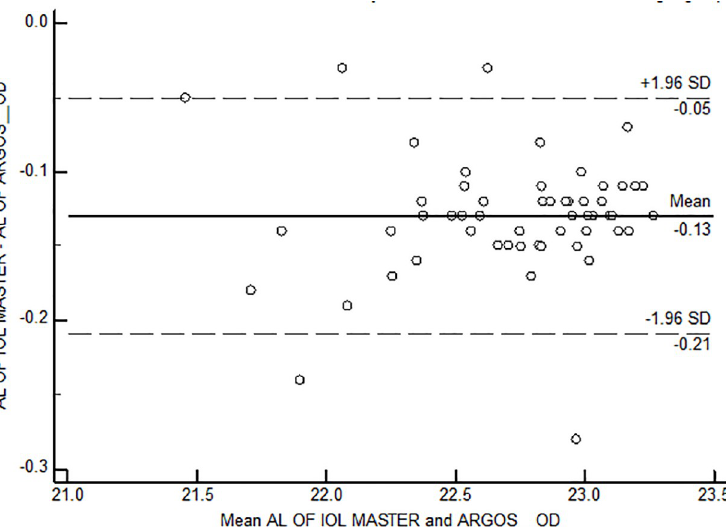
Fig 6. Bland Altman Plot for agreement between axial length measurements among short axial length group. AL-Axial length; OD–Right eye.